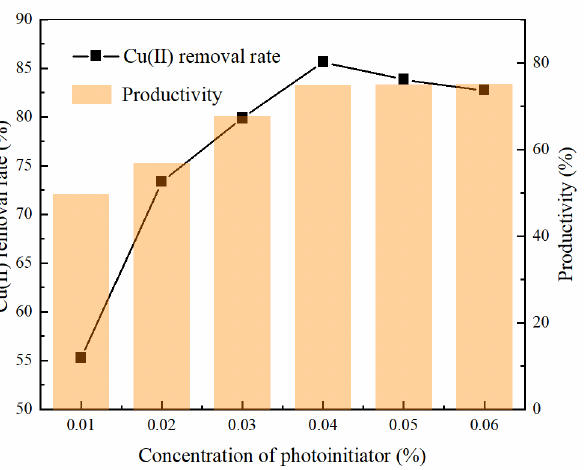
Figure 5. Effect of photoinitiator concentration on the productivity of MF@AA and Cu(II) removal efficiency.